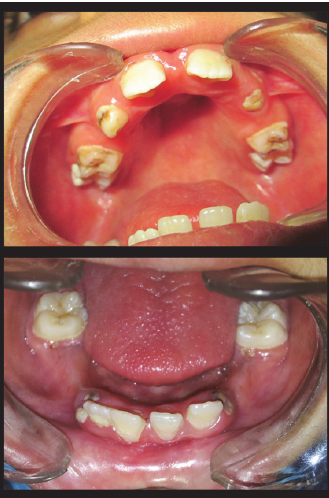
Figure 2: Intraoral view showing multiple carious lesions, reduced saliva, and missing primary dentition.